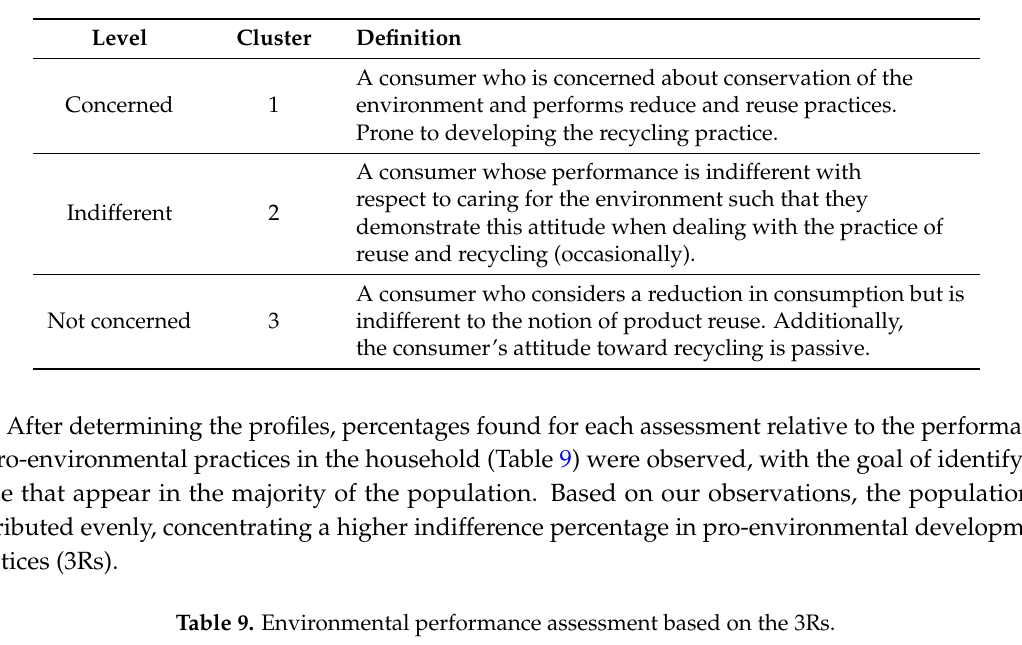
Table 8. Definition of consumers’ environmental behavior scale, based on 3Rs practices.